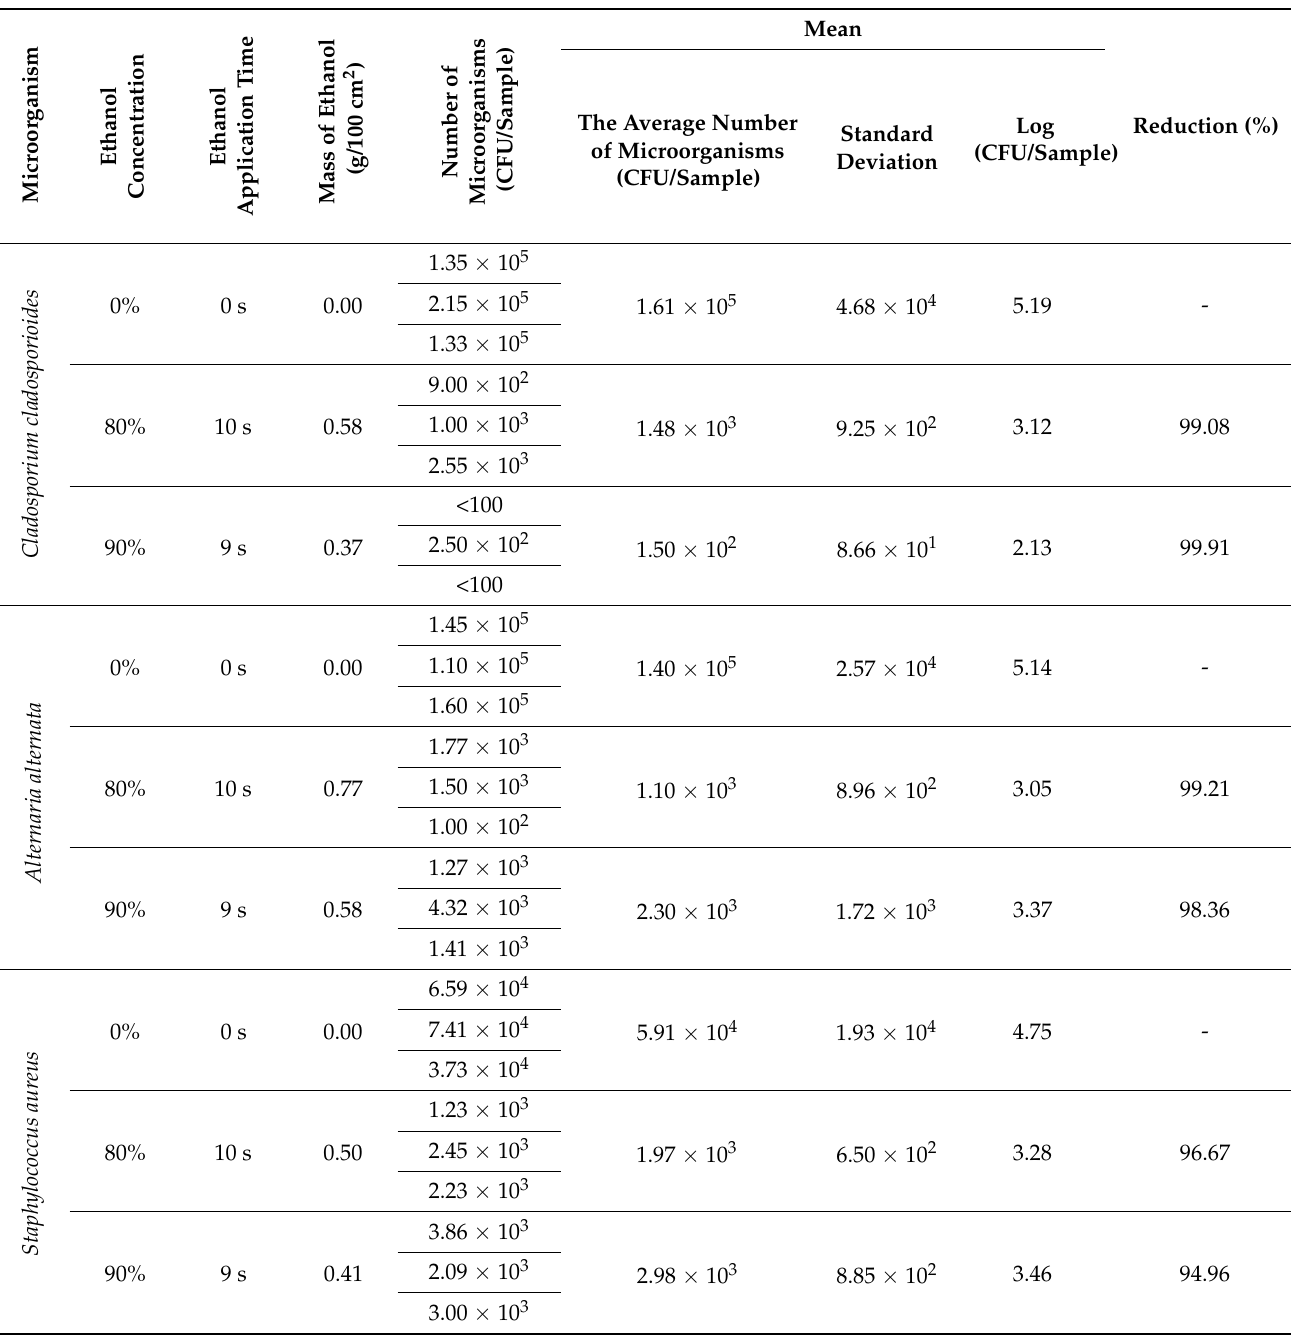
Table 1. Evaluation of biocidal effectiveness of the short-term action of ethanol in the form of mist against C. cladosporioides , A. alternata , S. aureus and A. niger on model